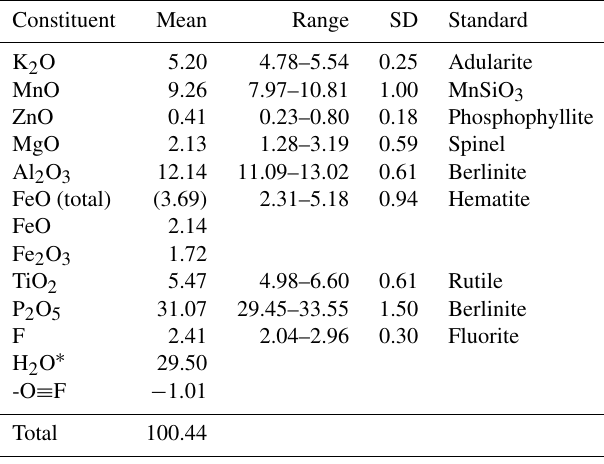
Table 1. Analytical data (wt%) for